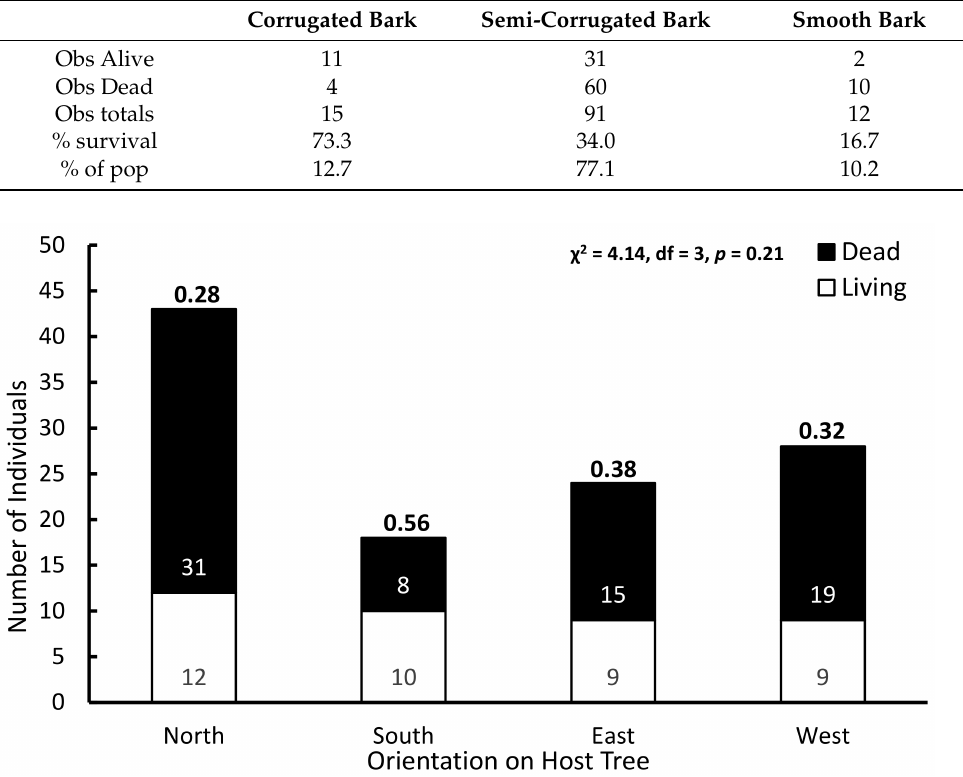
Figure 5. Total Campylocentrum pachyrrhizum observed from 2016–2022, organized by orientation on the host tree. Number of living and dead orchids appear inside of the bars. Survivorship of orchids at each orientation is listed at the top of each bar. The north orientation had the most individuals but also the lowest survivorship.